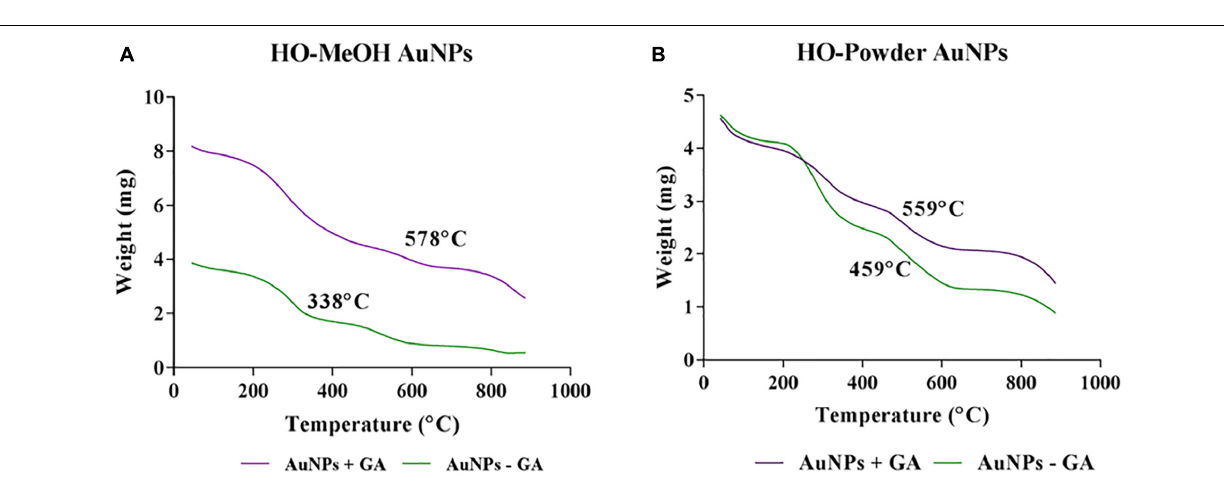
FIGURE 7 | Thermal stability of (A) Helichrysum odoratissimum methanol extract gold nanoparticles and H. odoratissimum leaf powder (B ) gold